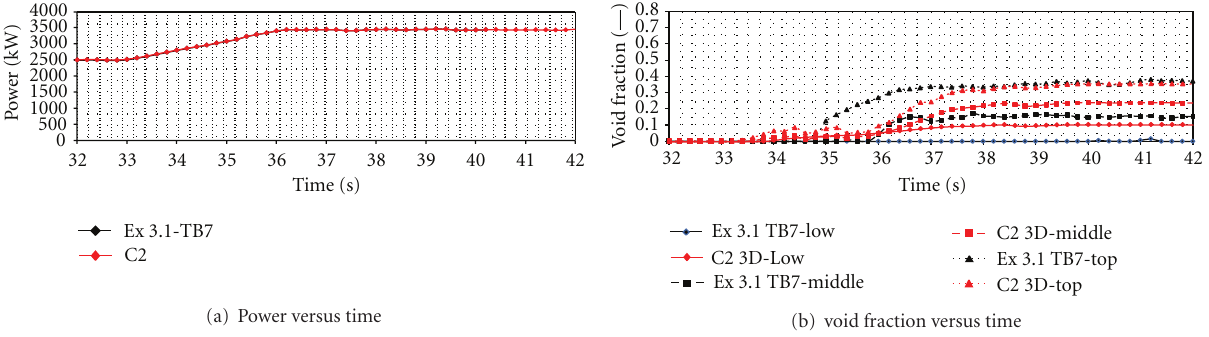
Figure 11: PSBT transient bundle tests (TS 7)—power increase—CATHARE2 3D: calc. versus exp., reference results